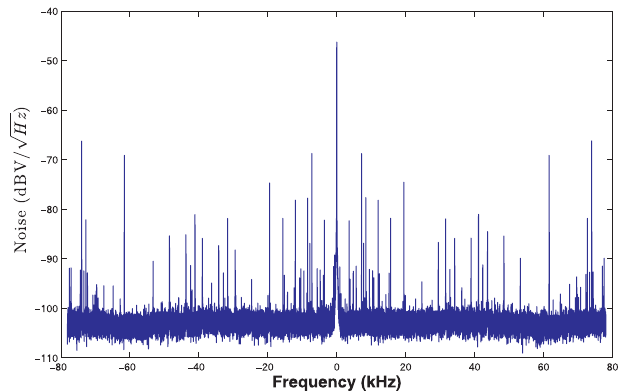
FIG. 6. (Color) Noise power spectral density at the output of the LHC rf feedback for channel Q (narrow